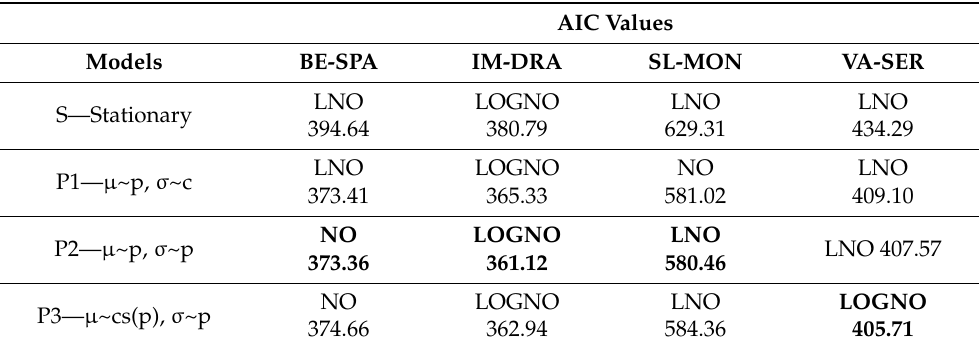
Table 3. Comparison of the best stationary and non-stationary models with rainfall as covariate. In bold are shown the distributions that provided the lowest AIC values between the analyzed distributions for each